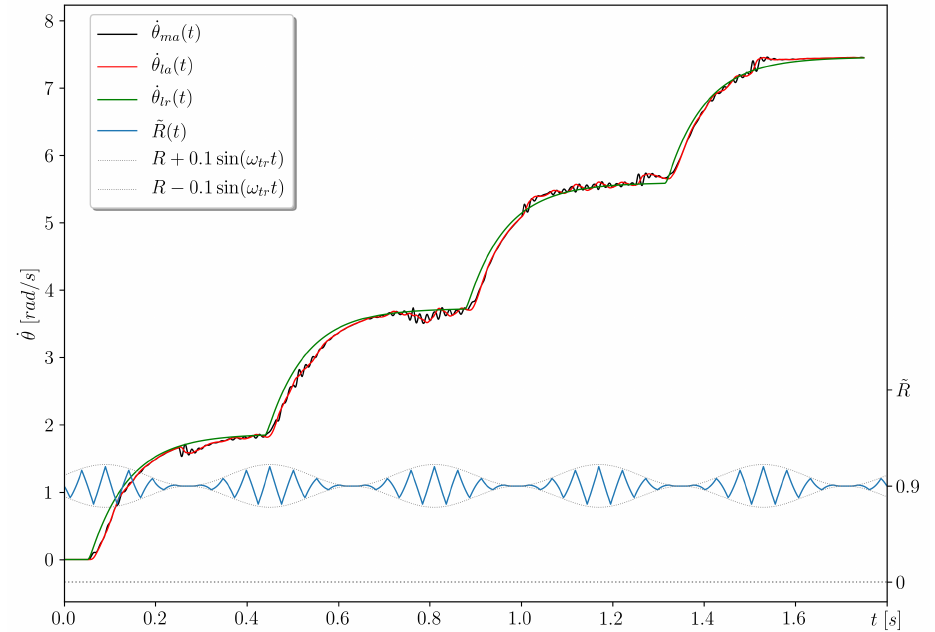
Figure 13. The closed-loop reference model FOPID control system response at the presence of low- frequency T la ( t ) and the disturbances of electric model parameters: R (see ˜ R ( t ) ) and L (not shown here as ˜ L ( t ) has an opposite and scaled form). This solution is comparable with Figure